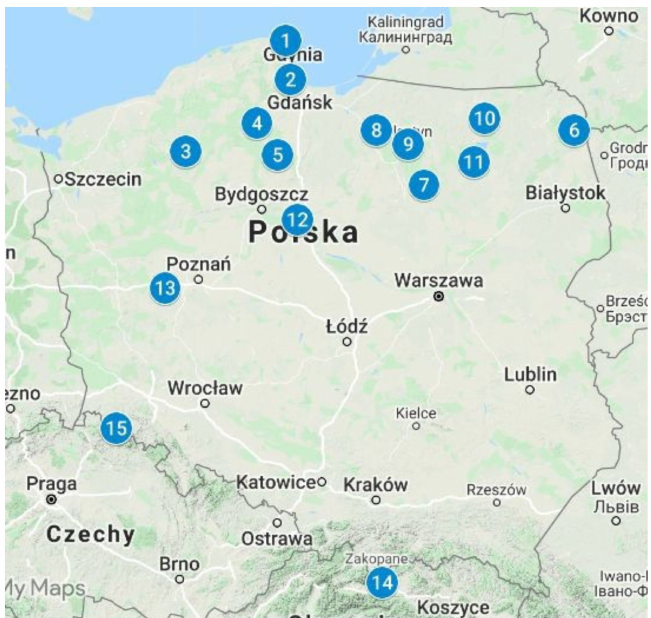
Figure 1. Sampling locations of King Bolete [(id1) Seacoast Landscape Park; (id2) Tricity Landscape Park, Osowa; (id3) Pomerania, Szczecinek; (id4) Wdzydze Landscape Park; (id5) Tuchola Pinewoods; (id6) August ó w Primeval Forest; (id7) Warmia land, Puchałowo; (id8) Warmia, Mor ˛ag; (id9) Warmia, Olsztyn; (id10) Mazury, Gi˙zycko; (id11) Mazury, Piska Forest; (id12) Kujawy, Toru´n forests; (id13) Greater Poland, Pora˙zyn; (id14) Tatra Mountains; (id15) Sudety Mountains, Kłodzka Dale] (see also Table